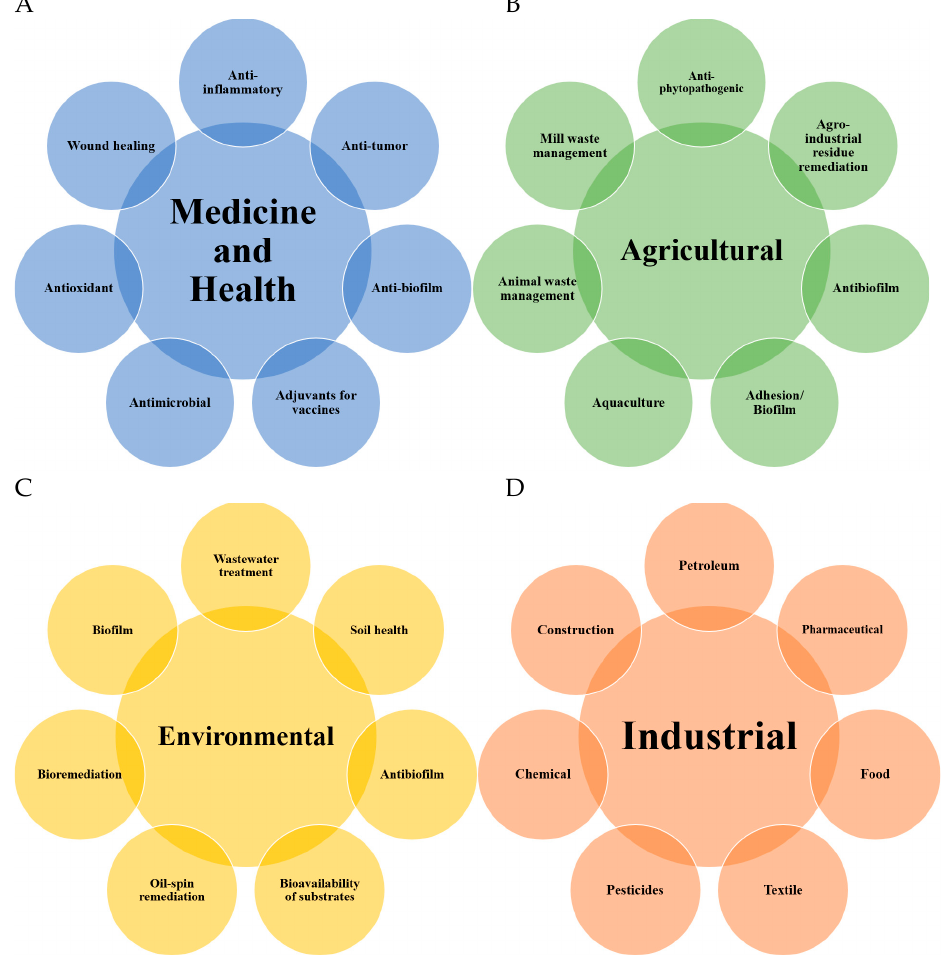
Figure 4. Properties and applications of biosurfactants in the ( A ) medical/health sector; ( B ) agricul- tural sector; ( C ) environmental sector; and ( D ) industrial sector. Source: modified from